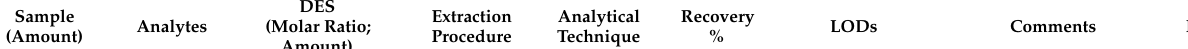
Extraction Analytical Recovery Procedure Technique %